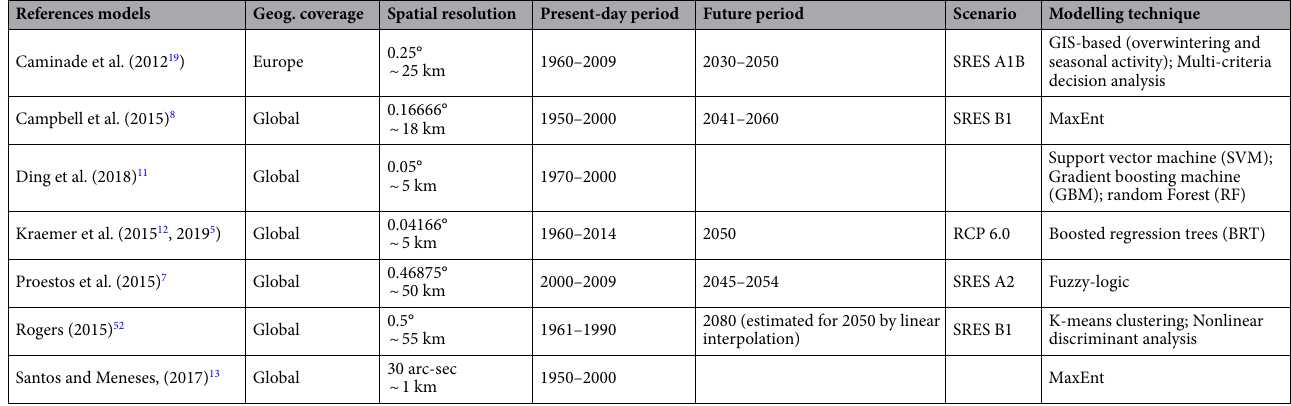
Table 1. Main characteristics of the input models and corresponding references. RCPs representative concentration pathways, SRES Special Report on Emissions Scenarios, GIS Geographic Information Systems. The scenario corresponds to the data layer used in our analysis. The original works may include results from other scenarios that were not analyzed, and these are detailed in the corresponding works